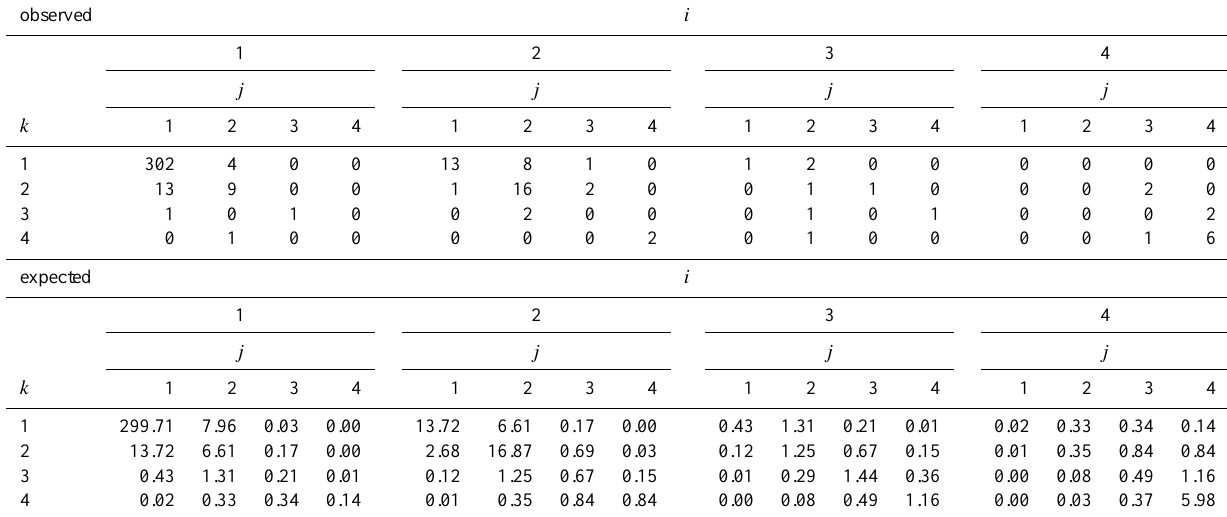
Table 9. Observed and expected drought class transitions for the Aison River Basin.